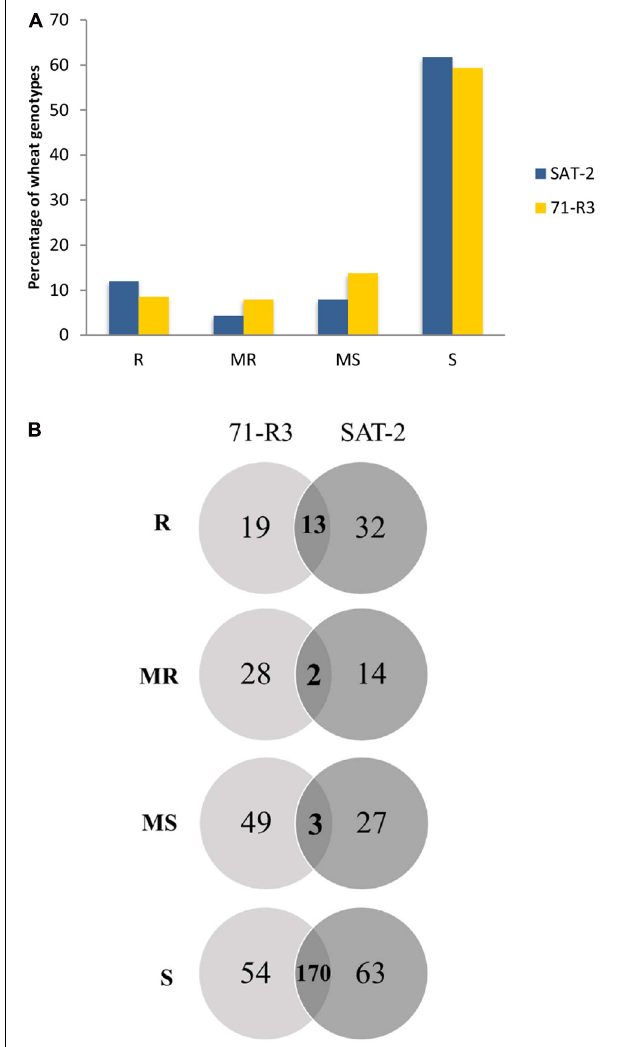
FIGURE 1 | Frequency distribution of 377 advanced breeding lines (ABLs) of spring bread wheat ABLs to two Septoria tritici blotch isolates SAT-2 and 71-R3 (A) . Venn diagram of infection responses of 377 ABLs to two Septoria tritici blotch isolates under controlled conditions from Morocco (B) . Here R, MR, MS, and S represent resistant, moderately resistant, moderately susceptible, and susceptible reaction types,